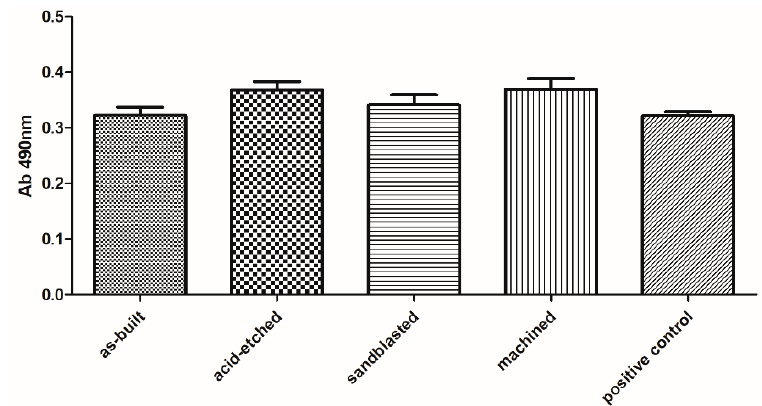
Figure 9. Survival of osteoblasts in media, in which surface-modified samples were immersed, compared to untreated osteoblasts (positive control box) (average values and standard deviation). No statistically significant differences were observed between particular groups (K-W test, P > 0.001).